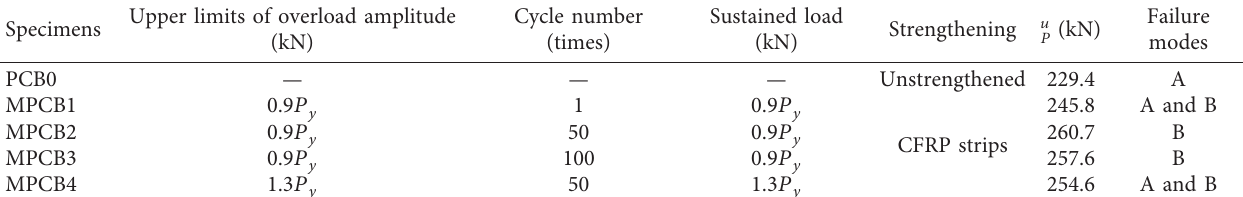
Table 1: Design parameters and results of test beams.